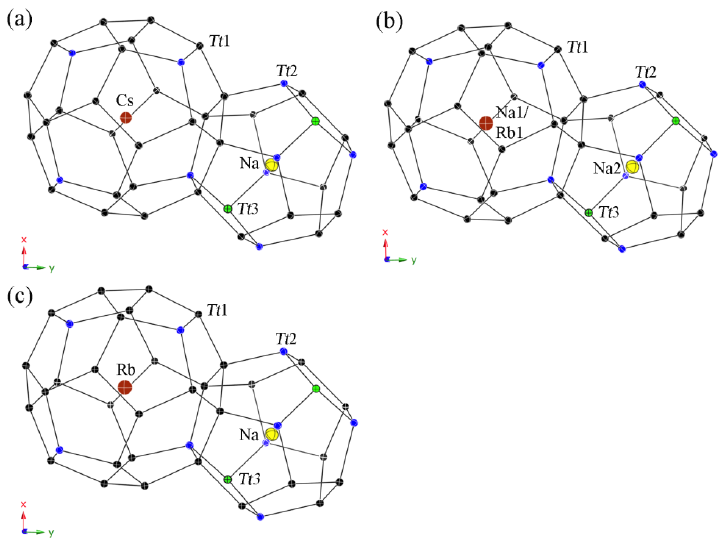
Na Ga Si ( a 8 16 22.7 113.3(1)